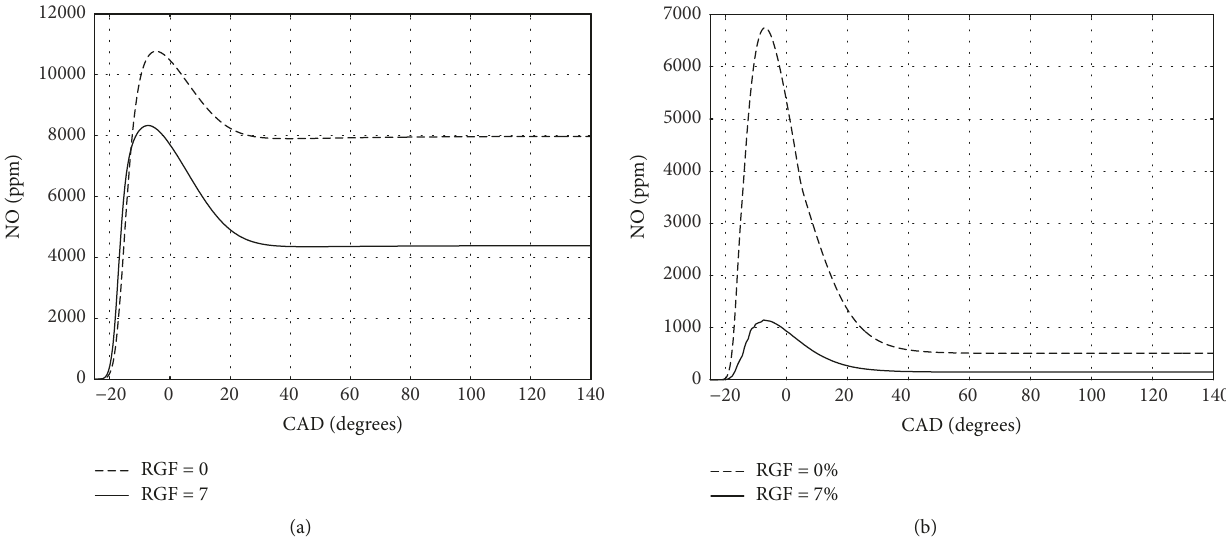
Figure 11: Temporal variation of in-cylinder NO: (a) lean mixture and (b) rich mixture.